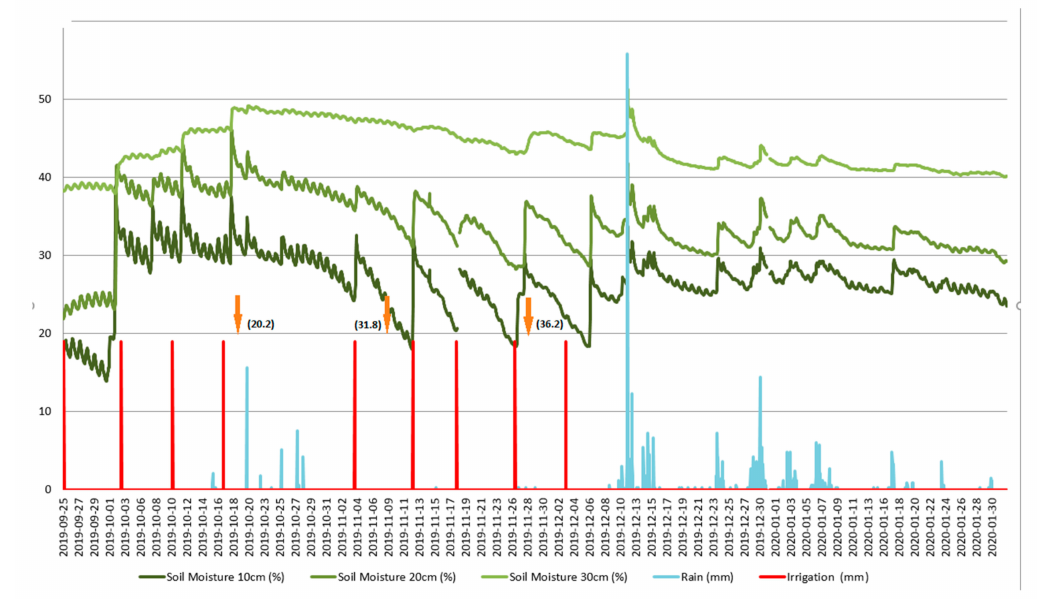
Figure 6. Recorded soil moisture in di ff erent depths combined with irrigation and rain events. Arrows imbedded in the figure show irrigation events (mm) and amounts according to Food and Agriculture Organization of the United Nations CropWat